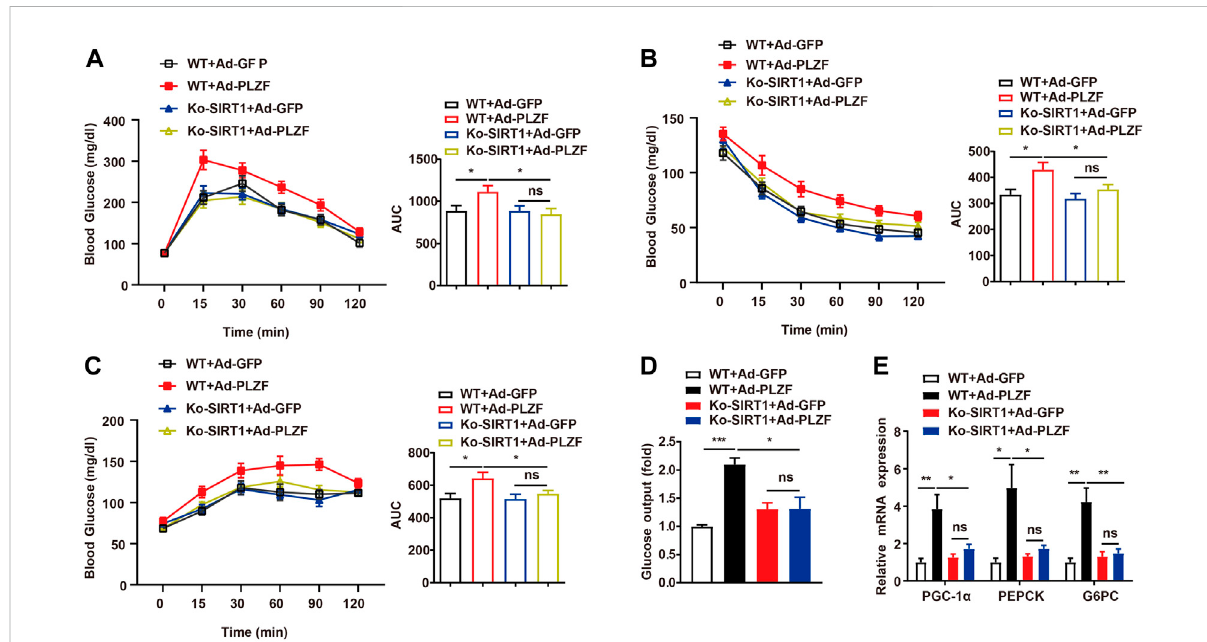
FIGURE 6 Hepatic PLZF overexpression impaired glucose tolerance and insulin sensitivity, which was dependent on SIRT1 deacetylases. Ad-GFP or Ad- PLZF adenovirus was injected into C57BL/6J mice (male) or Ko-SIRT1 mice. Blood glucose levels during (A) GTT, (B) ITT, and (C) PTT in mice that were infected with the indicated adenovirus. (D) Glucose production of the primary hepatocytes isolated from male C57BL/6J mice or Ko-SIRT1 mice infected with the indicated adenovirus. (E) For livers of mice infected with the indicated adenovirus, PGC-1 α , PEPCK, and G6PC were analyzed using qPCR. N = 6 – 8/group. For adenovirus injection, mice were injected via their tail vein with adenovirus. Then, 5 – 7 days after infection, mice livers and plasma were collected for further analysis. The data shown are the means ± SEM. * p < 0.05, ** p <